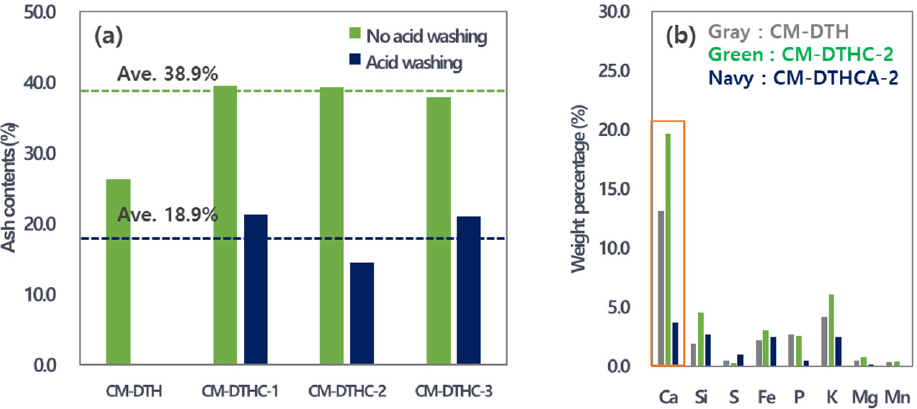
Figure 8. ( a ) Ash contents and ( b ) ash compositions of CM-DTHC with/without acid washing. All samples are based on CM-DTH-300.